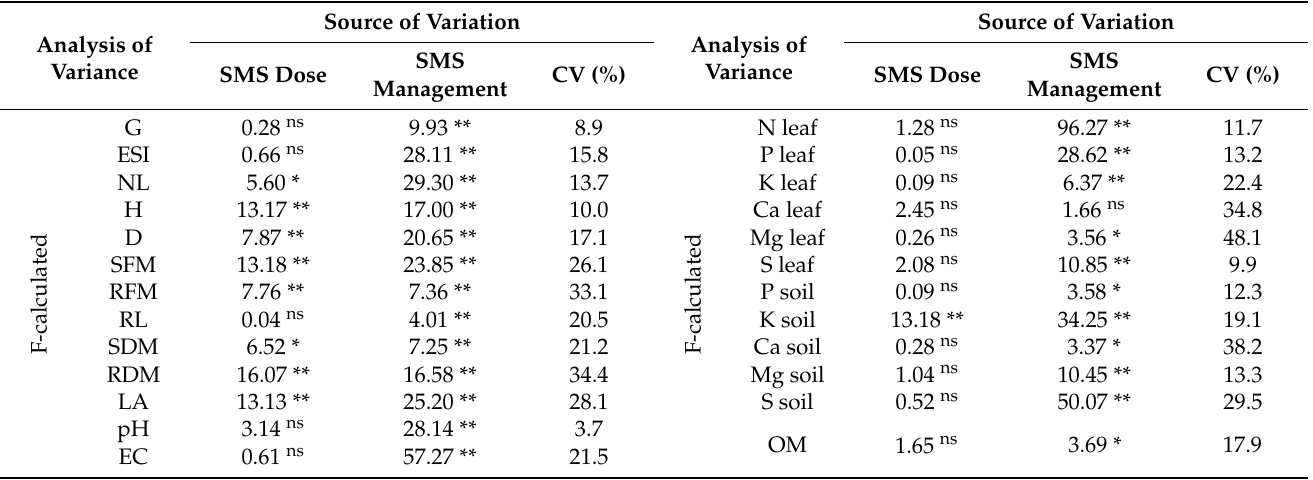
Table 2. Summary of the variance analysis of the factors (SMS dose and SMS management) on the biometric and chemical characteristics of maize plants cultivated in pots.